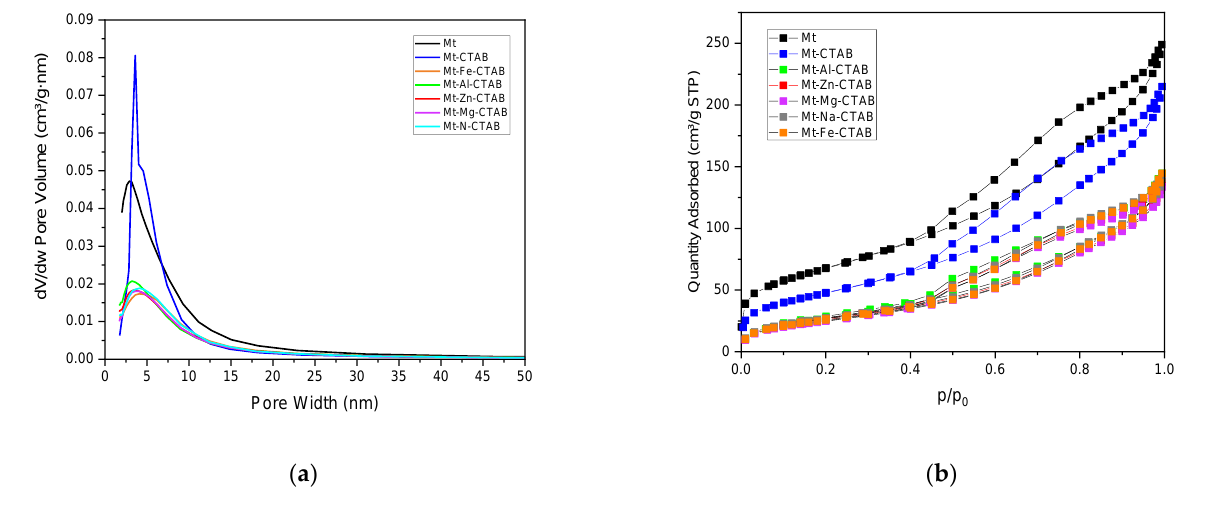
Figure 5. The pore size distribution estimated by the BJH model ( a ) of Mt- and CTAB-modified Mt 215 and N 2 adsorption-desorption isotherms ( b ). and N 2 adsorption-desorption isotherms ( b ).